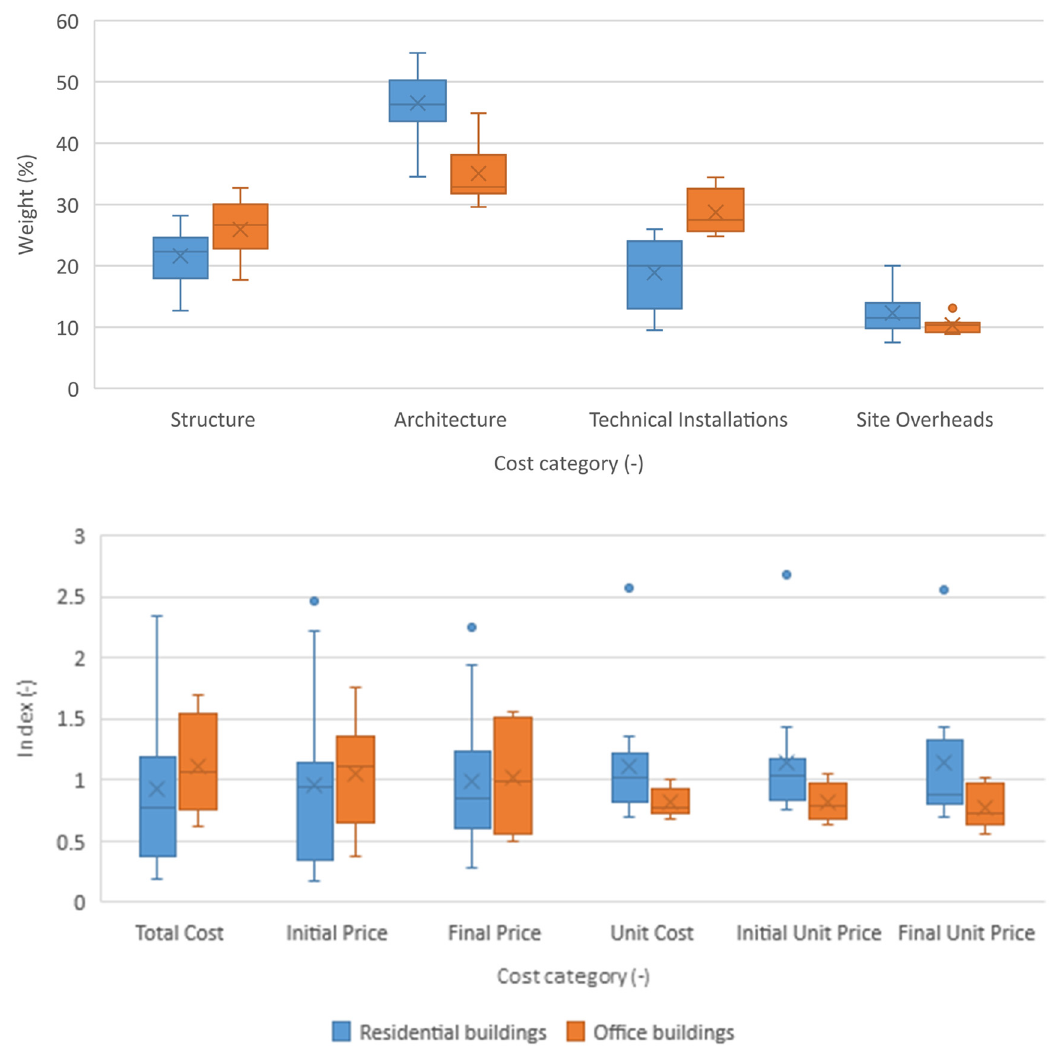
Figure 1. Projects distribution of the weight by cost category ( top ) and cost and prices indexes ( bottom ).